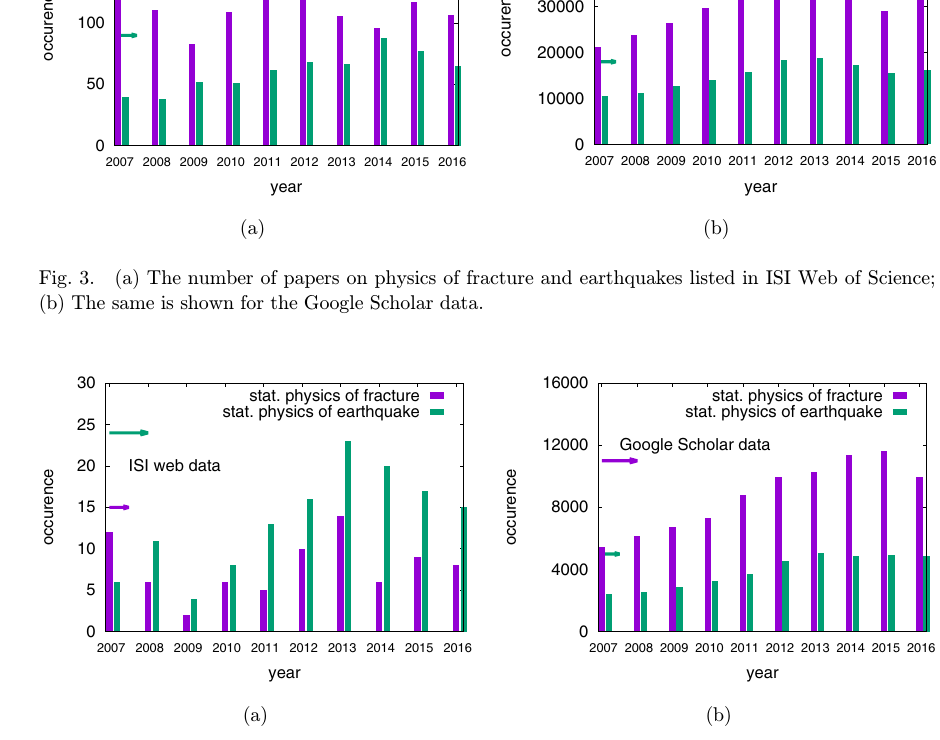
Fig. 4. (a) The number of papers on statistical physics of fracture and earthquakes listed in ISI Web of Science; (b) The same is shown for the Google Scholar data.